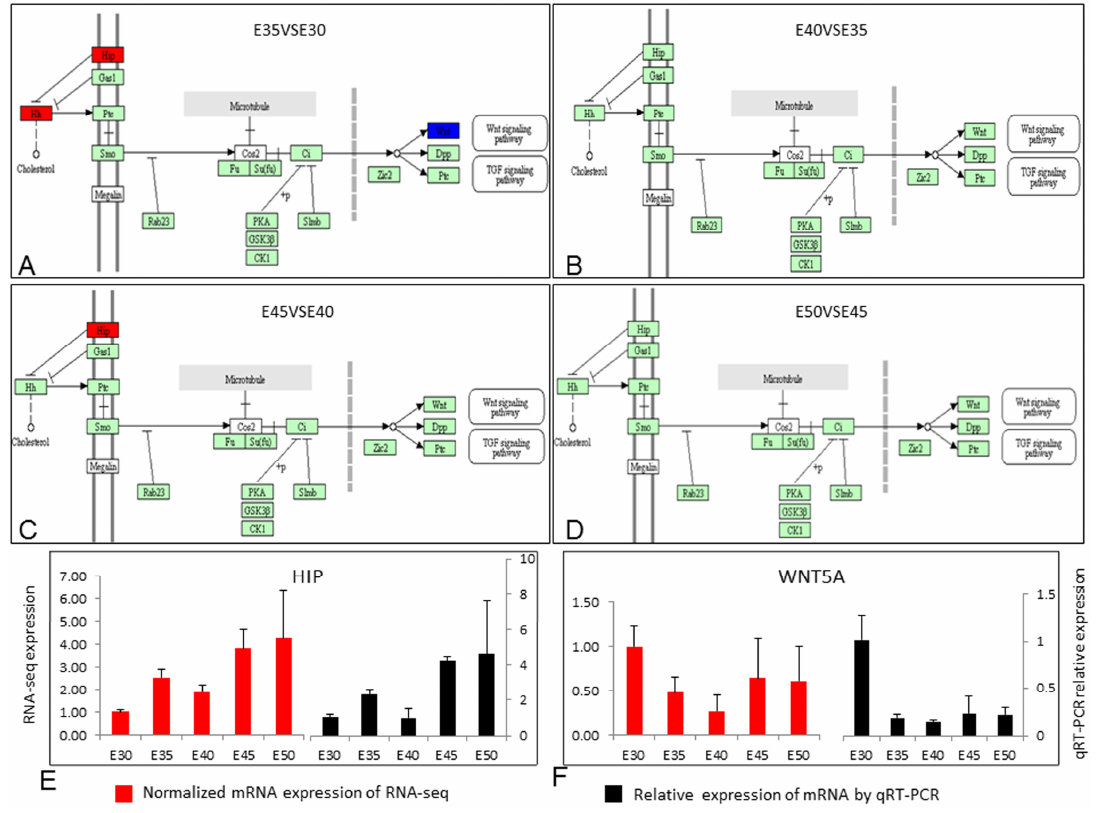
Figure 5. The different expression of HH (hedgehog) signaling. ( A – D ) Hedgehog signaling pathway (ko04340) expression between E35 and E30 ( A ); E40 VS E35 ( B ); E45 and E40 ( C ); E50 VS E45 ( D ). ( E ) Real-time reverse transcription-polymerase chain reaction (qRT-PCR) of HIP from E30–50. ( F ) qRT-PCR of WNT5A from E30–50.